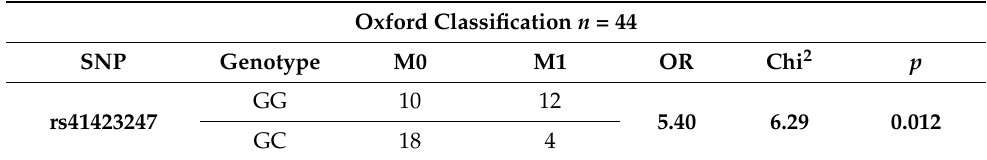
Table 7. Association between rs41423247 and Oxford classification of M parameter in IgAN kidney biopsies. Number of patients ( n ). M—mesangial hypercellularity in Oxford